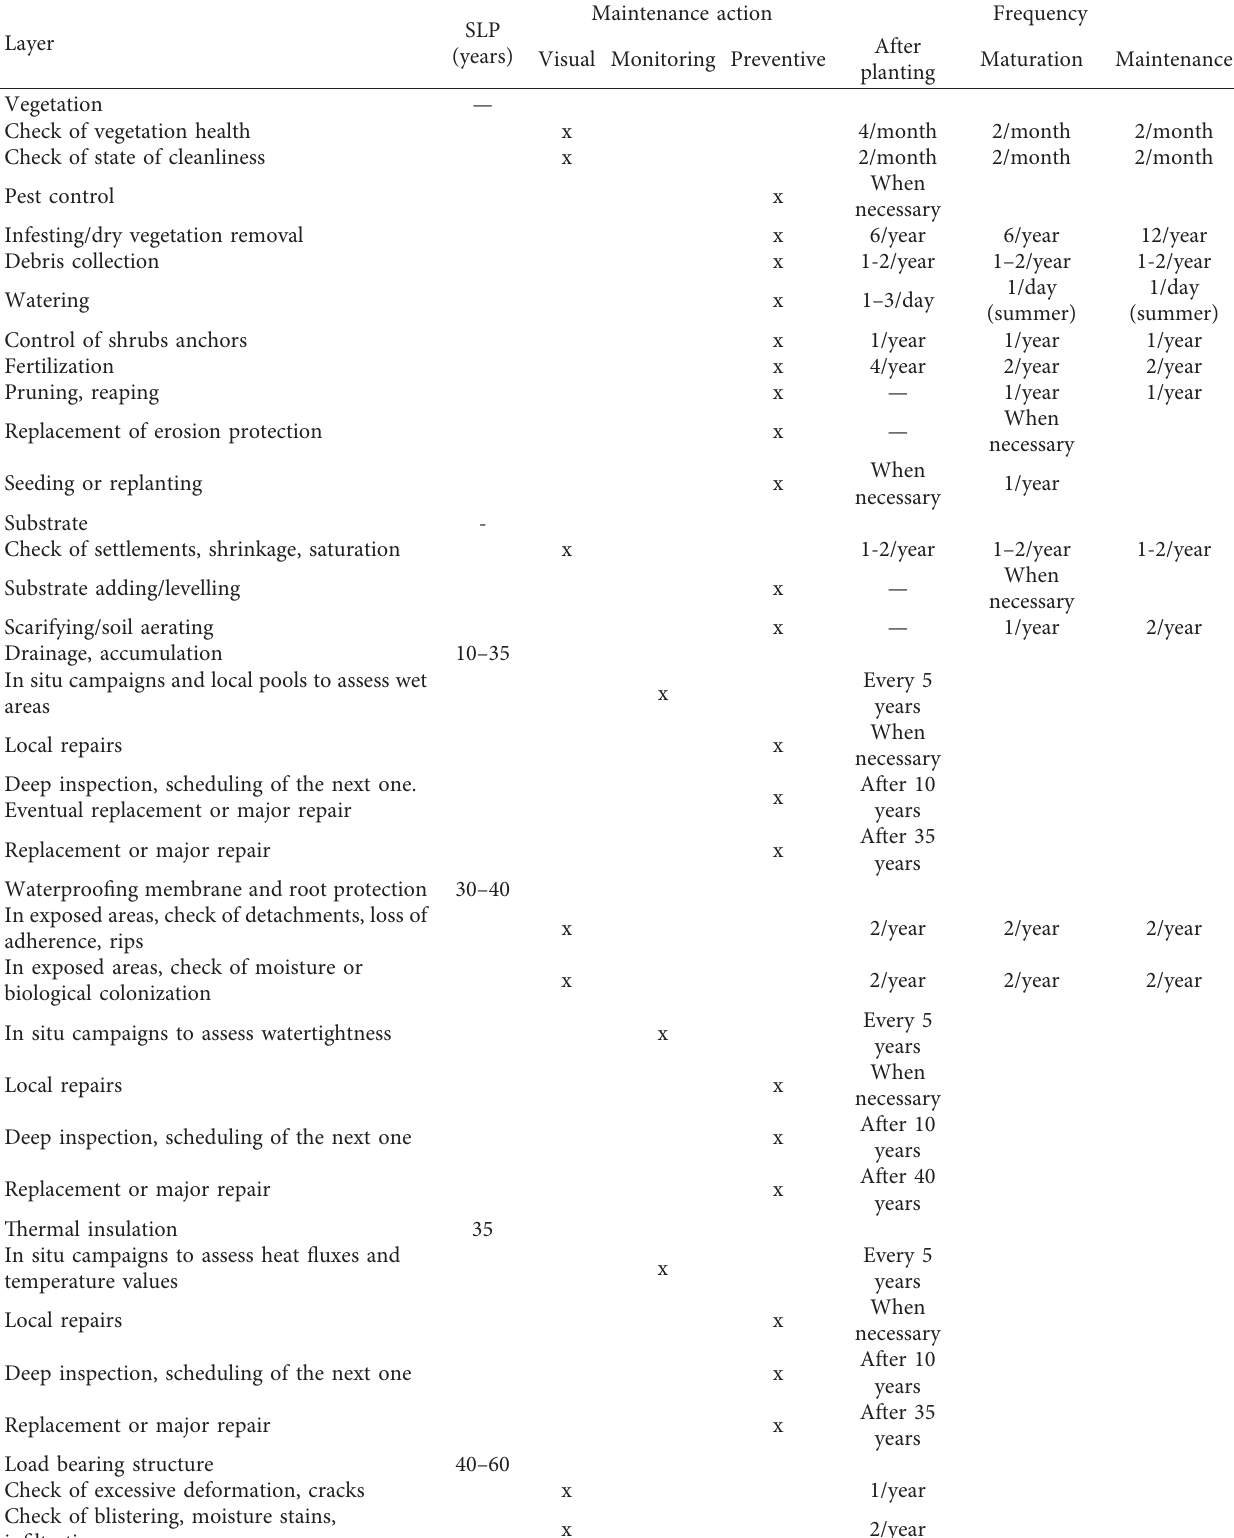
Table 9: Maintenance plan for the intensive green roof layers and their service life prediction (SLP) (the table is structured by authors upon data from [20] and authors own